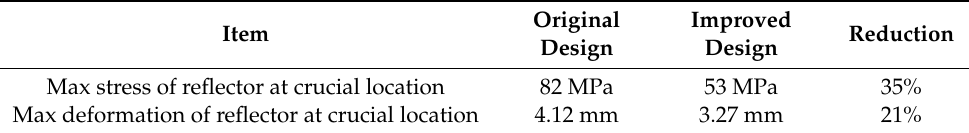
Figure 11. Results at crucial location between original design and improved design: ( a ) stress of original reflector at crucial location; ( b ) stress of improved reflector at crucial location; ( c ) deformation of original reflector at crucial location; ( d ) deformation of improved reflector at crucial location. Table 2. Comparison results at crucial location between original design and improved design.